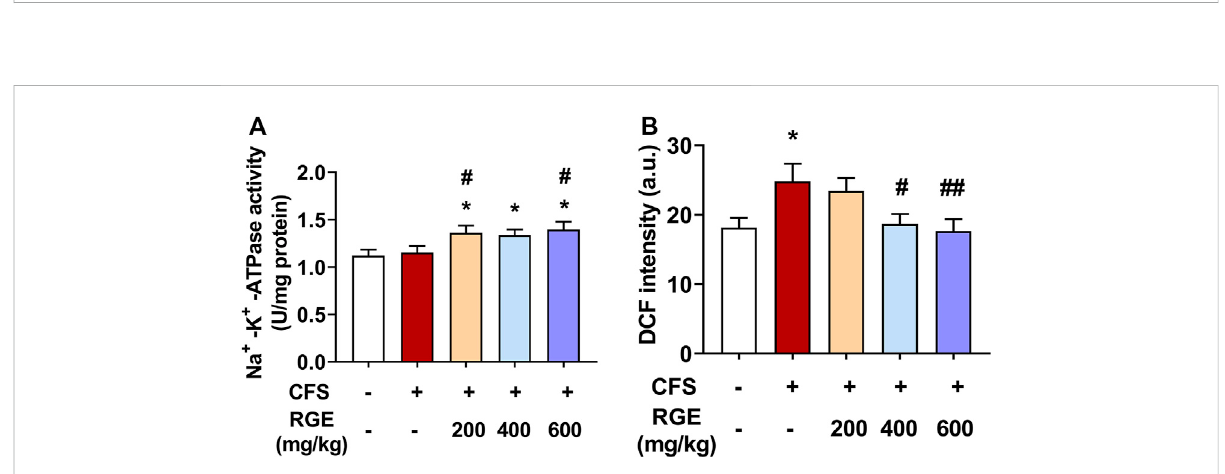
FIGURE 5 TheeffectsofRGEonskeletalmuscleNa + -K + -ATPaseactivityandmusclemitochondrialROS(DCFintensity)inchronicfatiguesyndromemice. (A – B) : Na + -K + -ATPase activity (A) and mitochondrial ROS (B) in TA muscles of the indicated groups. Mice from control or chronic fatigue syndrome model group were treated with water or different dose of RGE (200, 400 or 600 mg/kg). n = 6 per group. Compared with control group, * p < 0.05, ** p < 0.01; compared with CFS group, # p < 0.05, ## p <